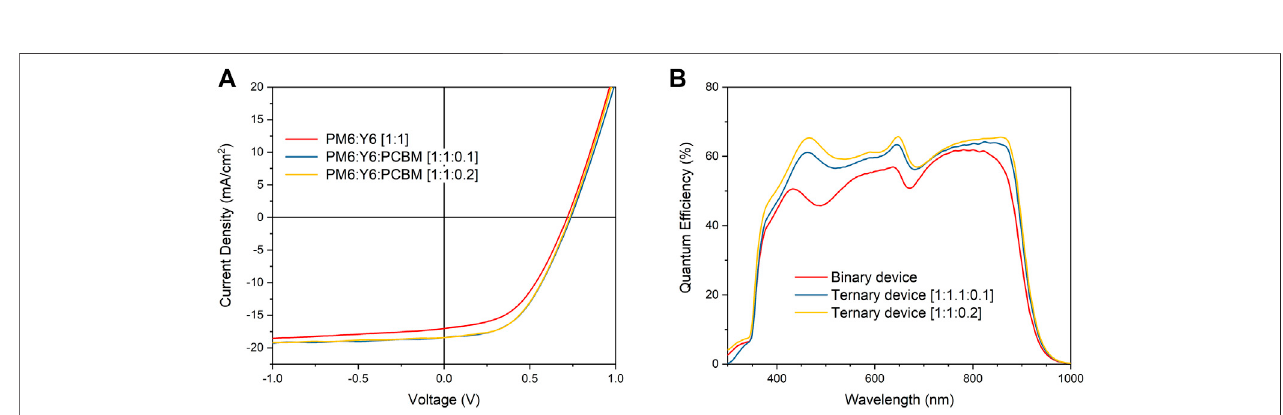
FIGURE 6 | (A) J-V curve comparison between binary and ternary devices and (B) QE comparison of PM6:Y6 based solar cells.